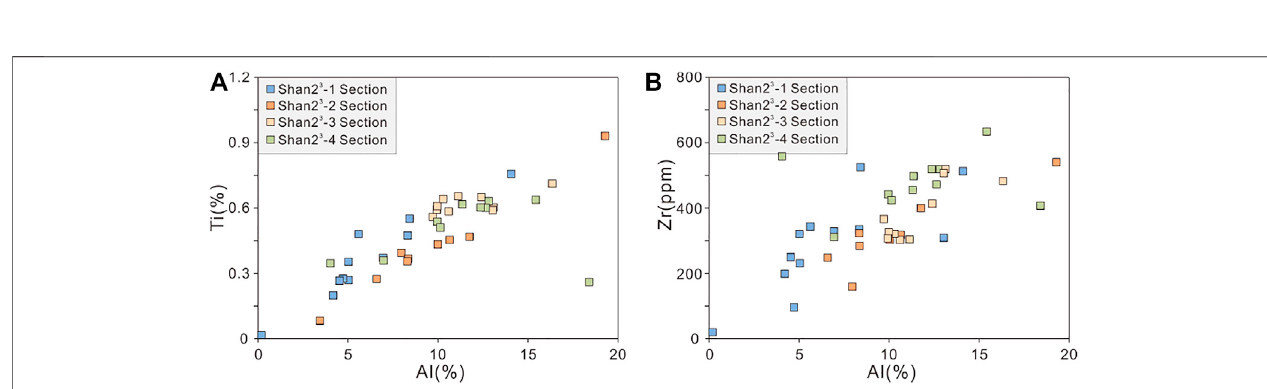
FIGURE 7 | (A) Crossplots of Ti-Al for Shanxi Formation Shan 2 3 Submember shale. (B) Crossplots of Zr-Al for Shanxi Formation Shan 2 3 Submember shale.